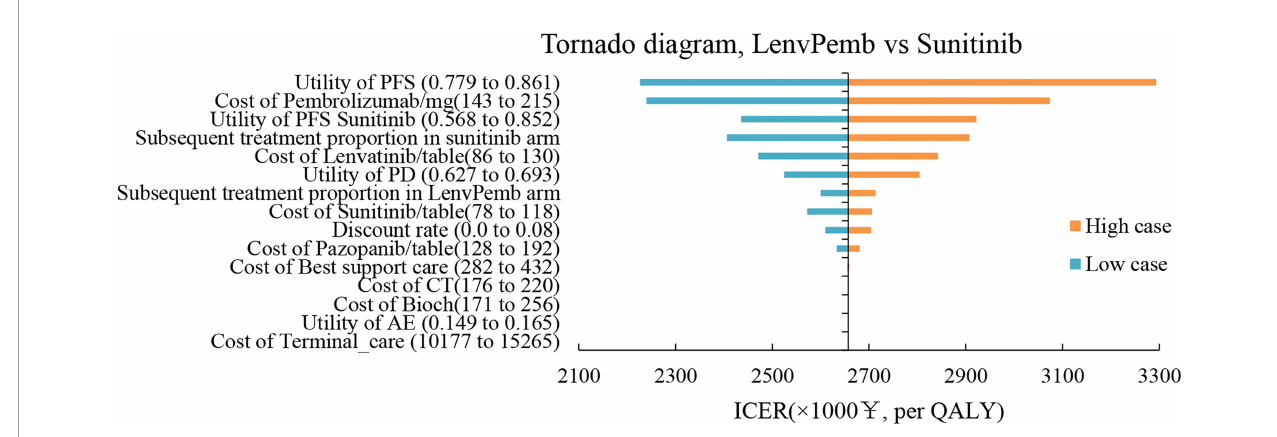
FIGURE 3 | Tornado Diagrams Showing the Effect of Lower and Upper Values of Each Parameter on the ICERs of the Lenvatinib-plus-Pembrolizumab Versus Sunitinib Strategy.